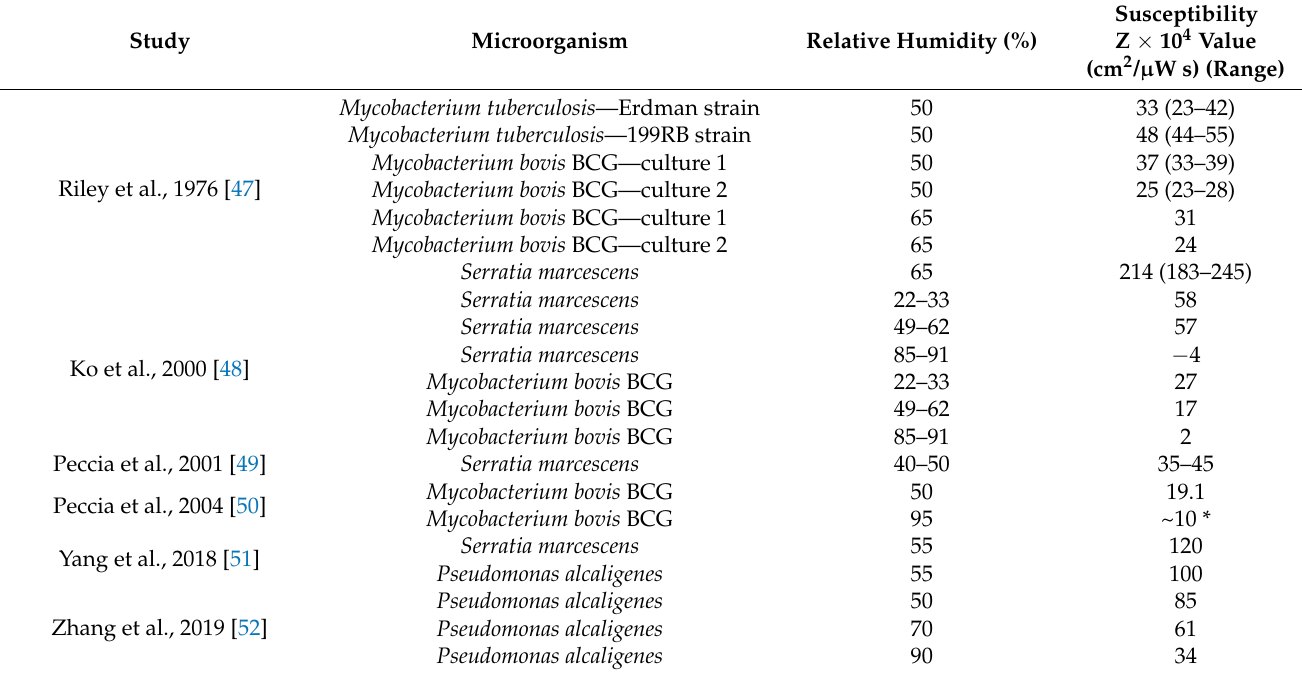
Table 1. Z-values of UV-C effects on respiratory bacteria at different relative humidity